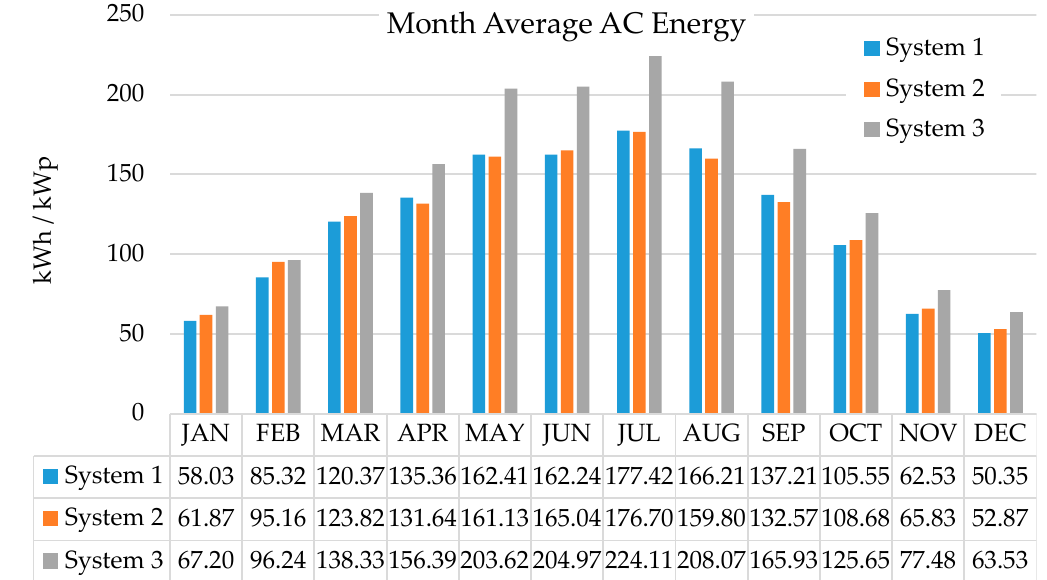
Figure 5. Monthly average energy supplied to the grid for the three systems under analysis. Values shown for each nominal kW installed. Table 3. Yearly energy production of each